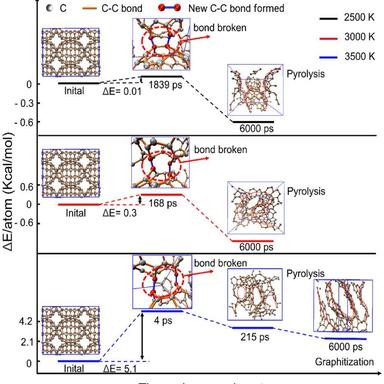
The structure and energy profile during the conversion of C70 fullerene crystals at 2500 K, 3000 K, and 3500 K. The energy of the initial C70 fullerene crystal was set as the reference level. (A colour version of this figure can be viewed online.)